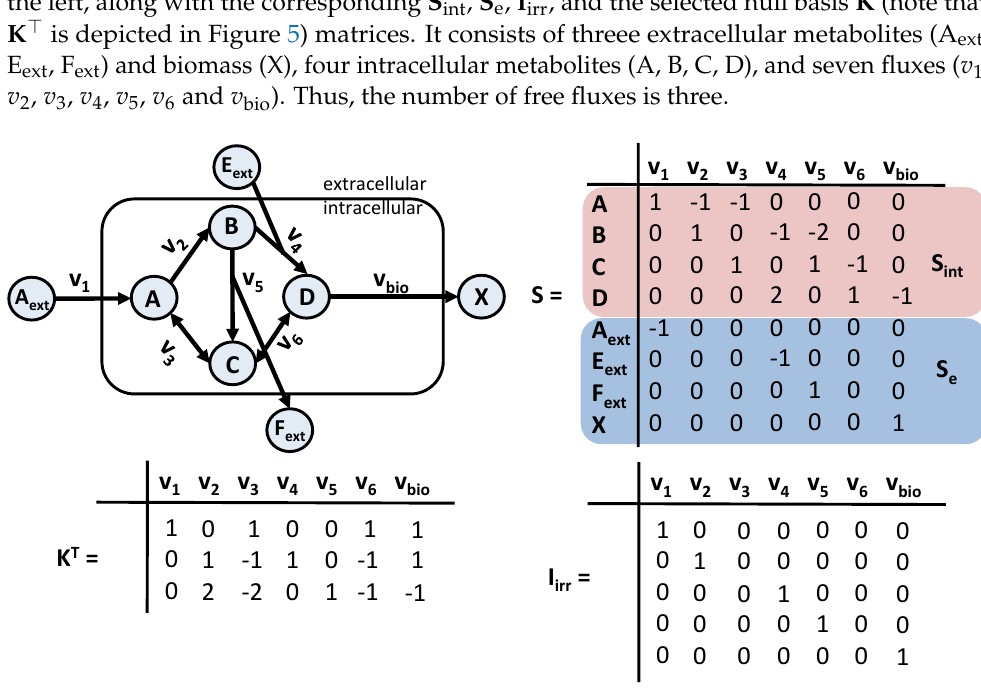
Figure 5. Metabolic network and characterizing matrices for the CSTR bioreactor case